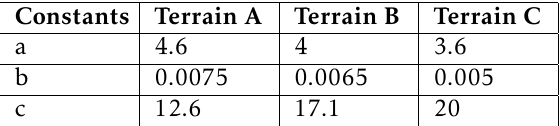
Table 3. Parameters for different terrains (SUI